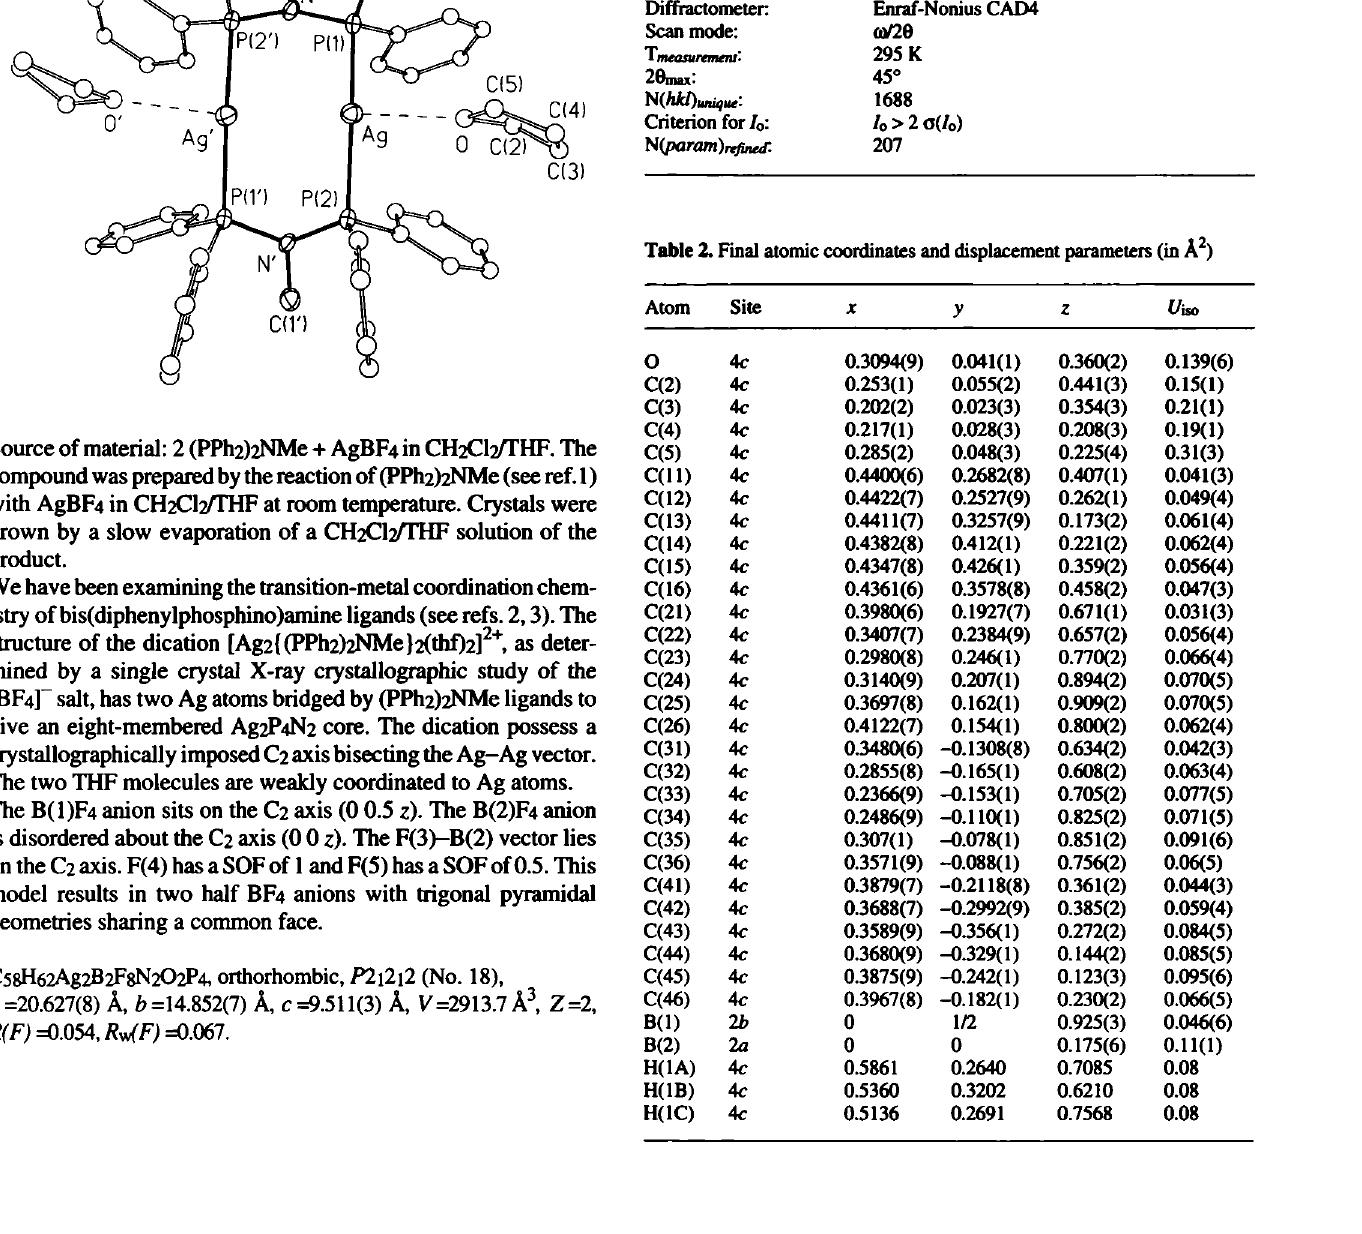
Table 2. Final atomic coordinates and displacement parameters (in Â 2